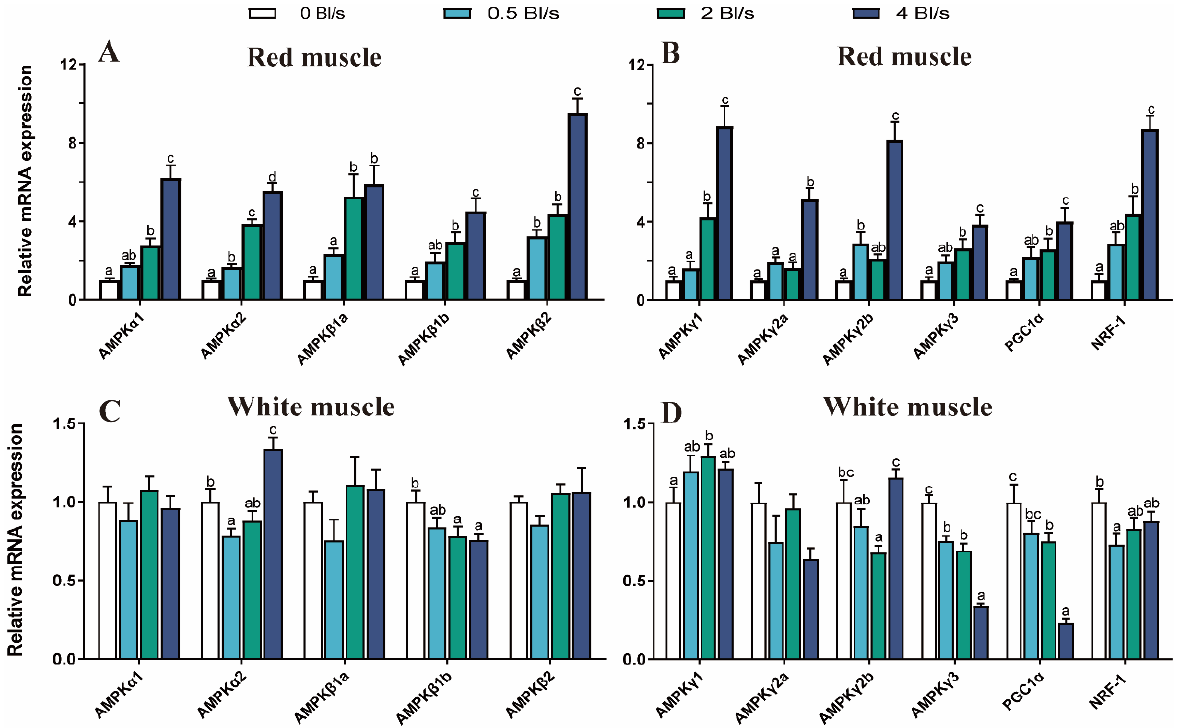
Figure 5. Effect of water velocity AMPK signaling pathway of grass carp in muscle. ( A ) AMPKα and β families mRNA expression levels in red muscle. ( B ) AMPK γ family, PGC- 1α and NRF-1 mRNA expression levels in red muscle. ( C ) AMPKα and β families mRNA expression levels in white muscle. ( D ) AMPK γ family, PGC- 1α and NRF-1 mRNA expression levels in white muscle. Data are means ± SEM (n = 9 fish per treatment). Different letters indicate significant differences between treatments ( p < 0.05).